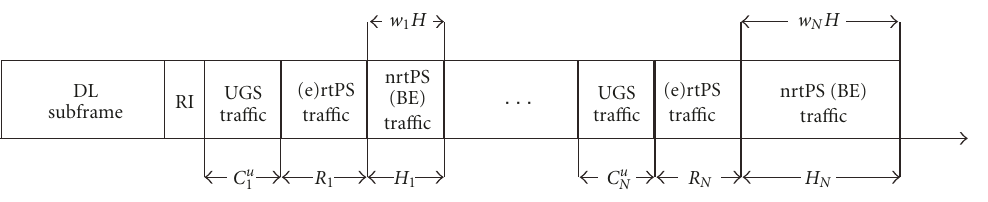
Figure 5: The capacity allocation